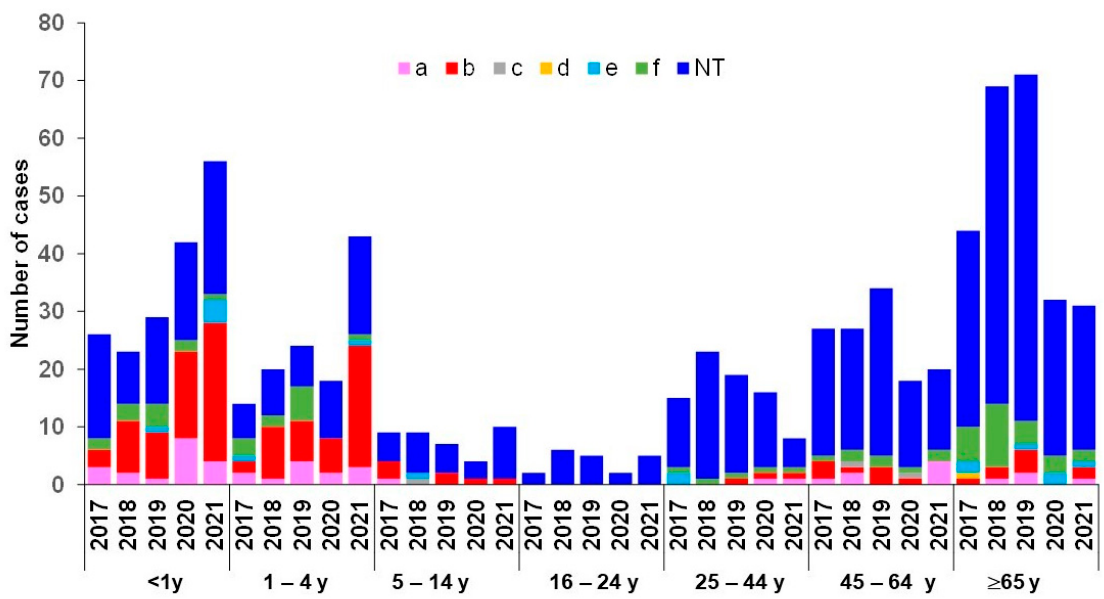
Figure 5. Evolution of number of cases of IHiD over the period 2017–2021 per age group and per serotype.